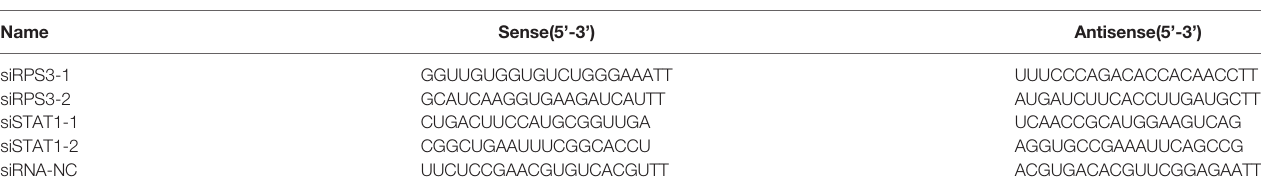
TABLE 1 | Small interfering RNA (siRNA) and miRNA-mimic used in transfection.